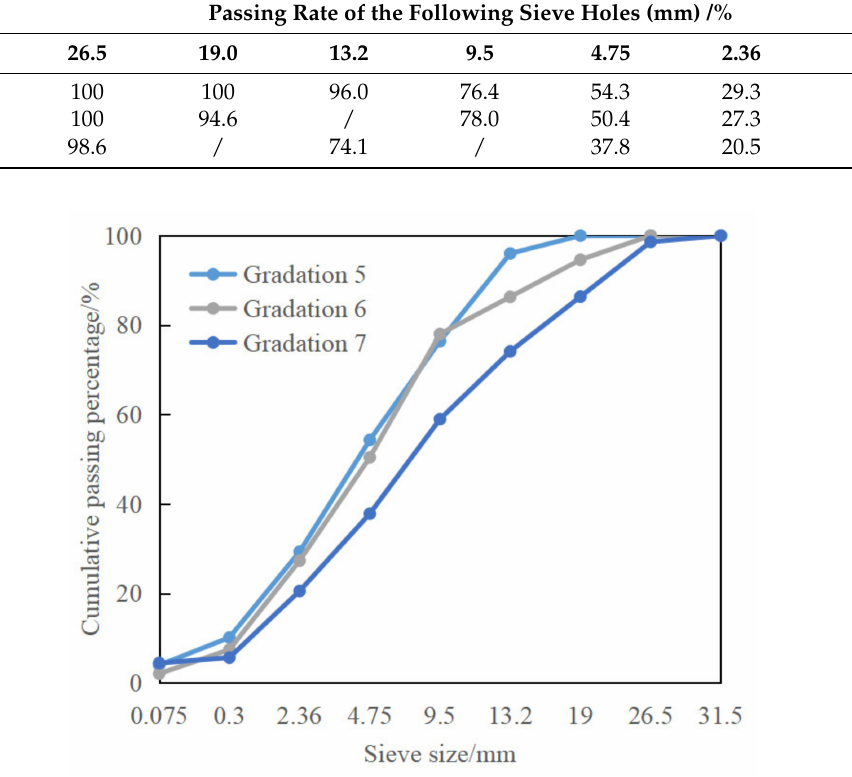
Figure 2. Three gradation types of